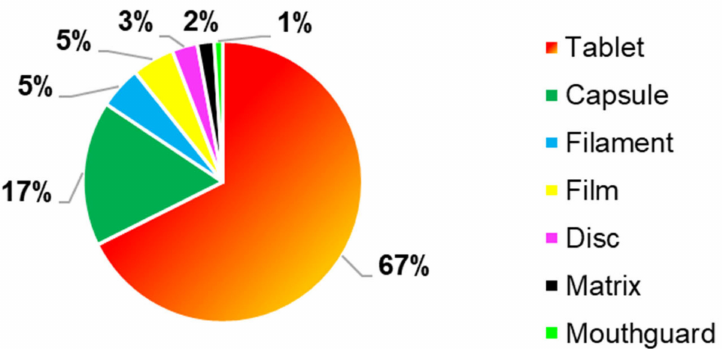
Figure 6. Representation and quantification of the main 3DP formulations manufactured using FDM 3DP technique, (1) tablets (red), (2) capsules (dark green), (3) filaments (blue), films (yellow), discs (pink), matrices (black) and mouthguard (light green).